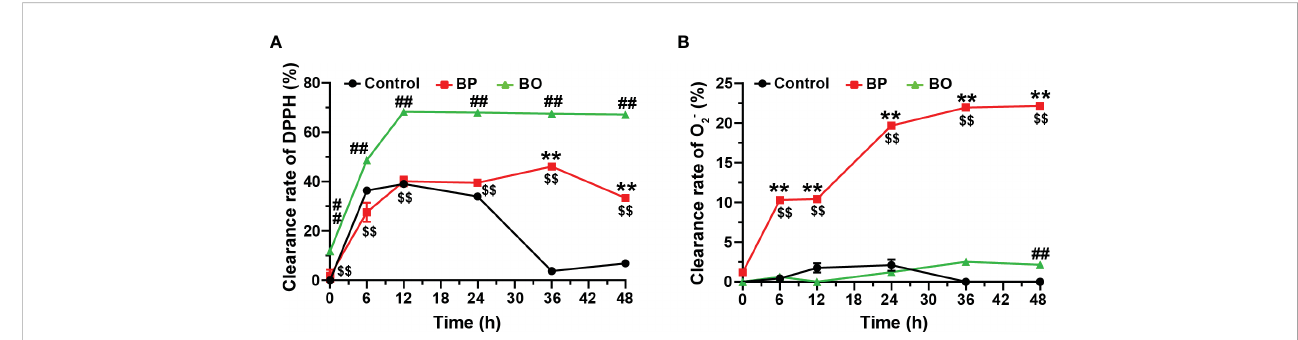
FIGURE 8 Scavenging effects of fermentation broth in BP and BO groups on DPPH and superoxide anion (O 2 -) free radicals. (A) Clearance rate of DPPH by BP or BO fermentation broth. (B) Clearance rate of O 2 - by BP or BO fermentation broth. Data were presented as mean ± SD (n = 3). ** p < 0.01, Control group vs. BP group; ## p < 0.01, Control group vs. BO group; $$ p < 0.01, BP group vs.. BO